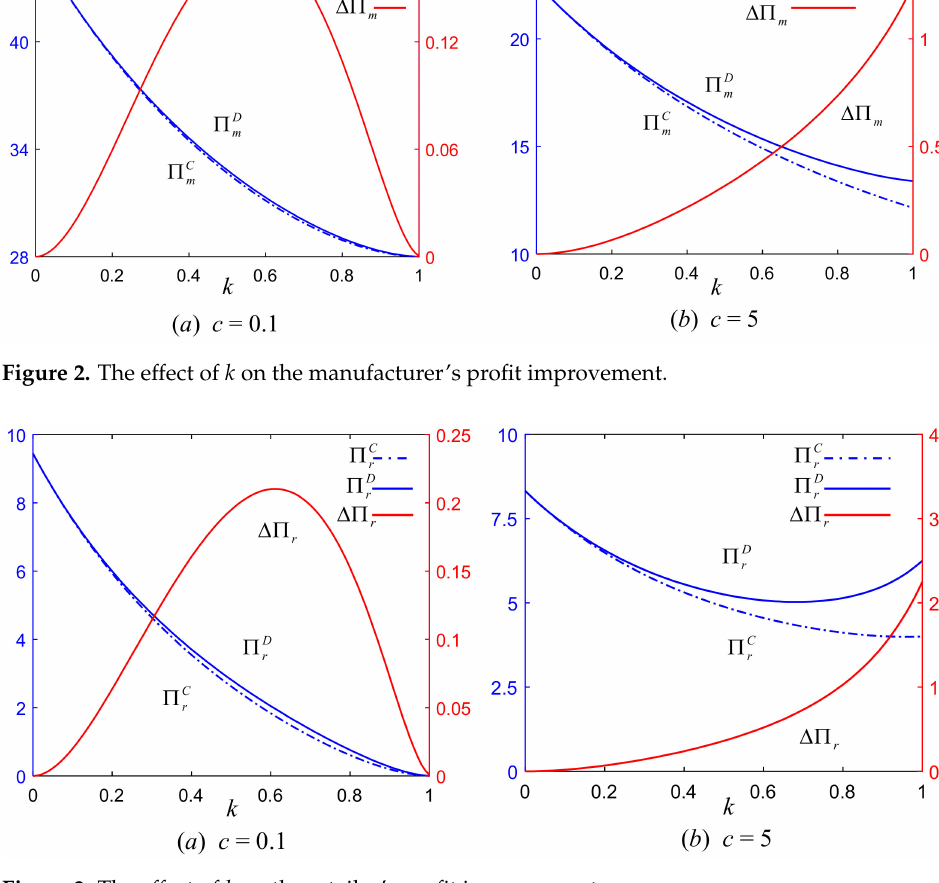
Figure 3. The effect of k on the retailer’s profit